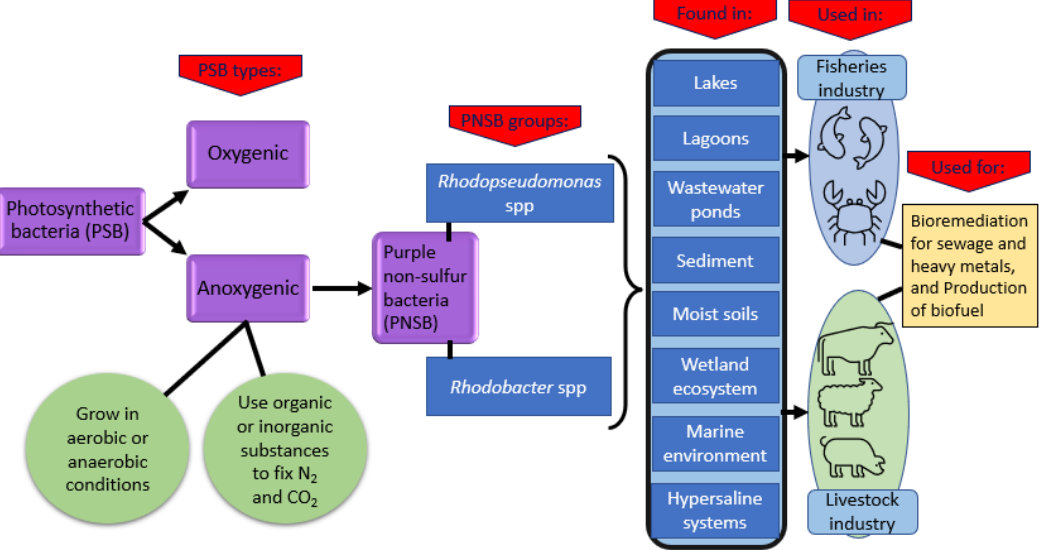
Figure 1. A brief overview of purple non-sulfur bacteria and their benefits to the environment.